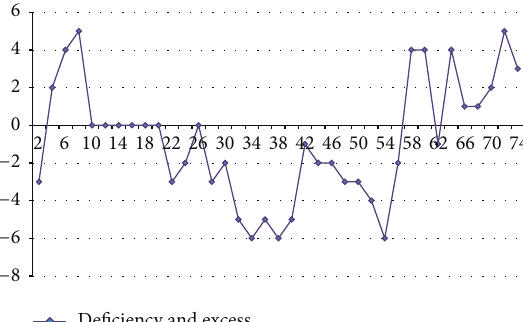
Figure 12: Variation of